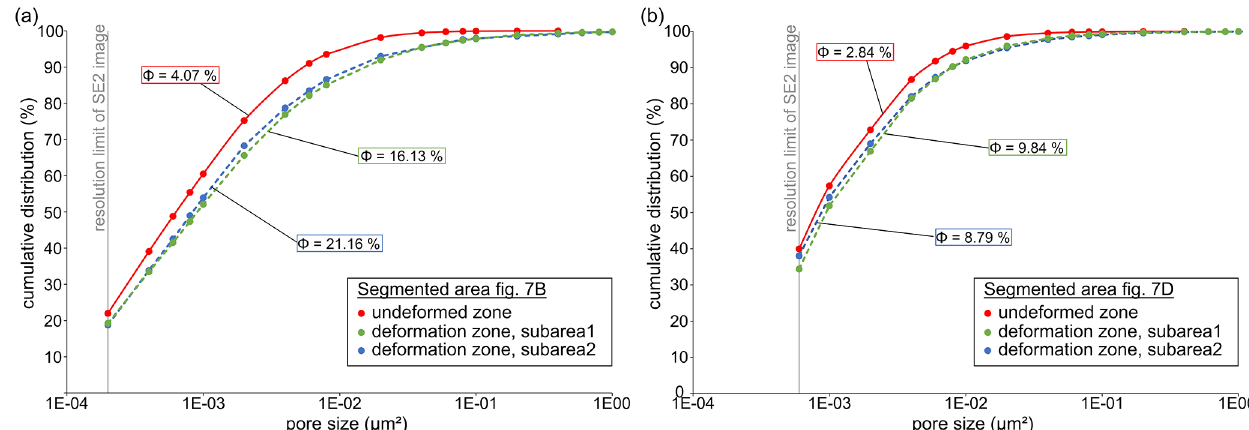
Figure 8. Pore size distributions of undeformed and deformed OPA based on SE2 image segmentation from Fig. 7b and d. Deformed zones present an increased porosity by a factor of 4 to 5 and show a higher portion of larger pores. Note that porosities estimated from SEM image segmentation are underestimated due to the limited image resolution of 2 × 10 − 4 µm 2 and 6 × 10 − 4 µm 2 , respectively.